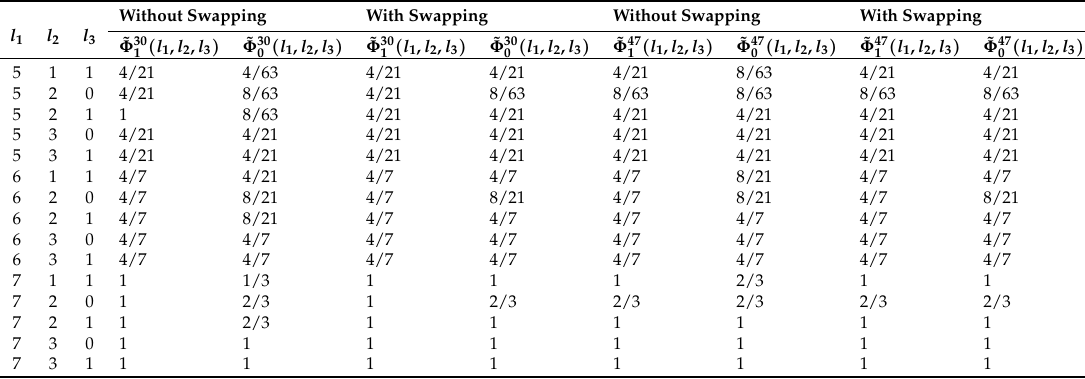
Table A3. ˜ Φ 1 and ˜ Φ 0 for components 30 and 47 without and with swapping (rows with ˜ Φ ( l 1 , l 2 , l 3 ) = 0 are omitted).